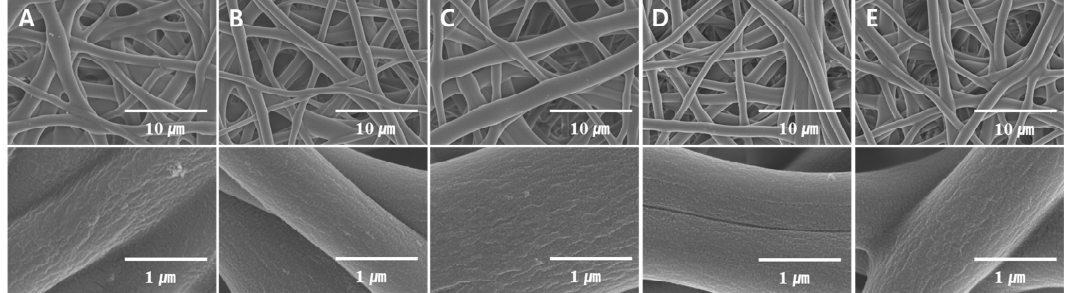
Figure 3. FE-SEM images of saponified PVA nanofiber mats obtained at different saponification times: ( A ) 6 h; ( B ) 12 h; ( C ) 18 h; ( D ) 24 h; and ( E ) 30 h. The quantities of the reagents in the saponification solution (NaOH = 10 g, Na 2 SO 4 = 10 g, MeOH = 10 g, and H 2 O = 10 g) and the reaction temperature were kept constant (25 °C).